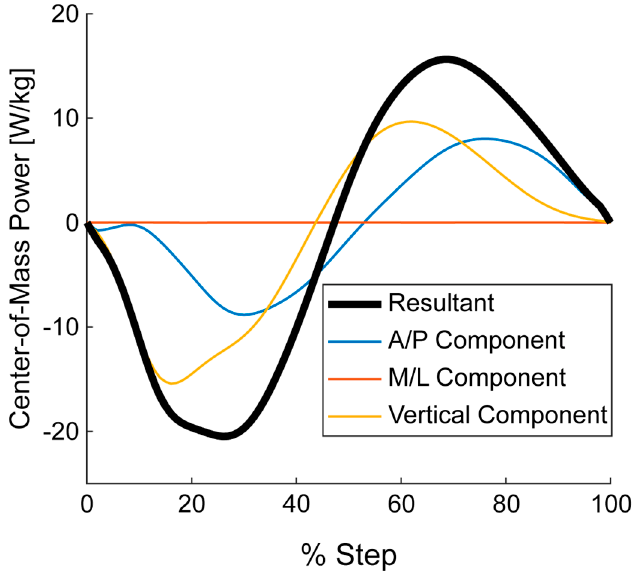
Figure 1. Center − of − Mass (COM) power components for running at 3.0 m/s on level ground. The three different components of the COM power were computed respectively from the anterior/posterior (A/P), medial/lateral (M/L), and vertical components of the ground reaction force. The sagittal plane components (i.e., vertical and A/P) have the greatest contribution to the COM power. Presented data are from one representative subject.